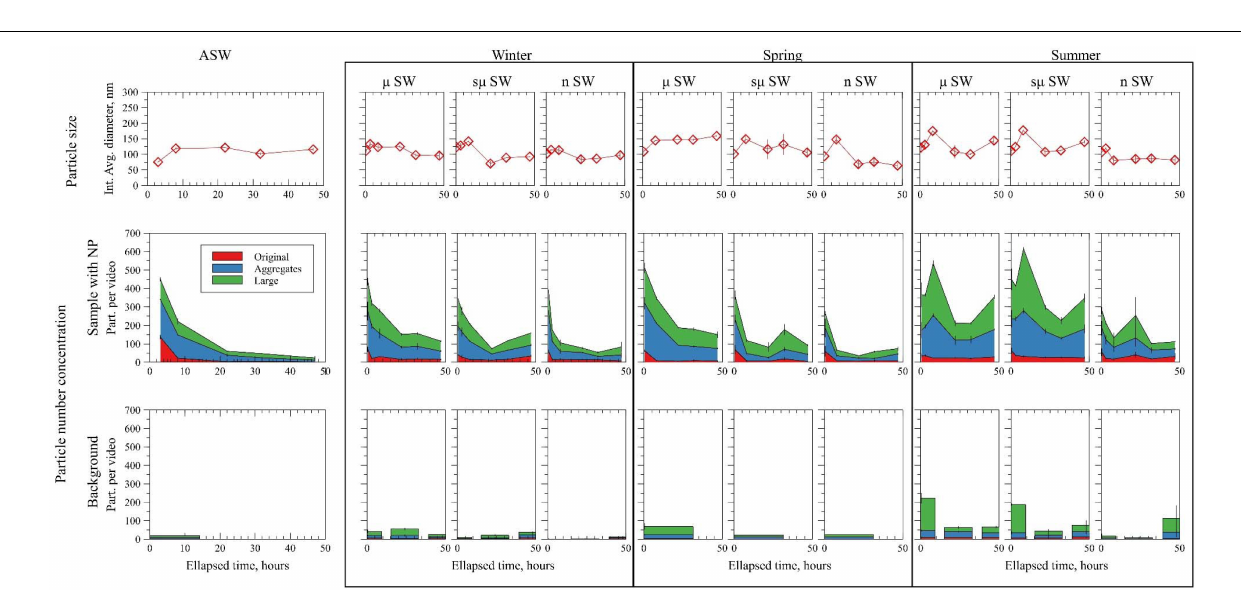
FIGURE 4 | Evolution in time of the intensity averaged diameter from NTA, concentration of particles from NTA in samples with AuNP and in the background. Original, aggregates and large particles are described in the text and Figure 3 . Two replicates of the fractionated samples (nSW, suSW, and uSW as explained in text) are presented. Background samples (without AuNP spike) are presented when